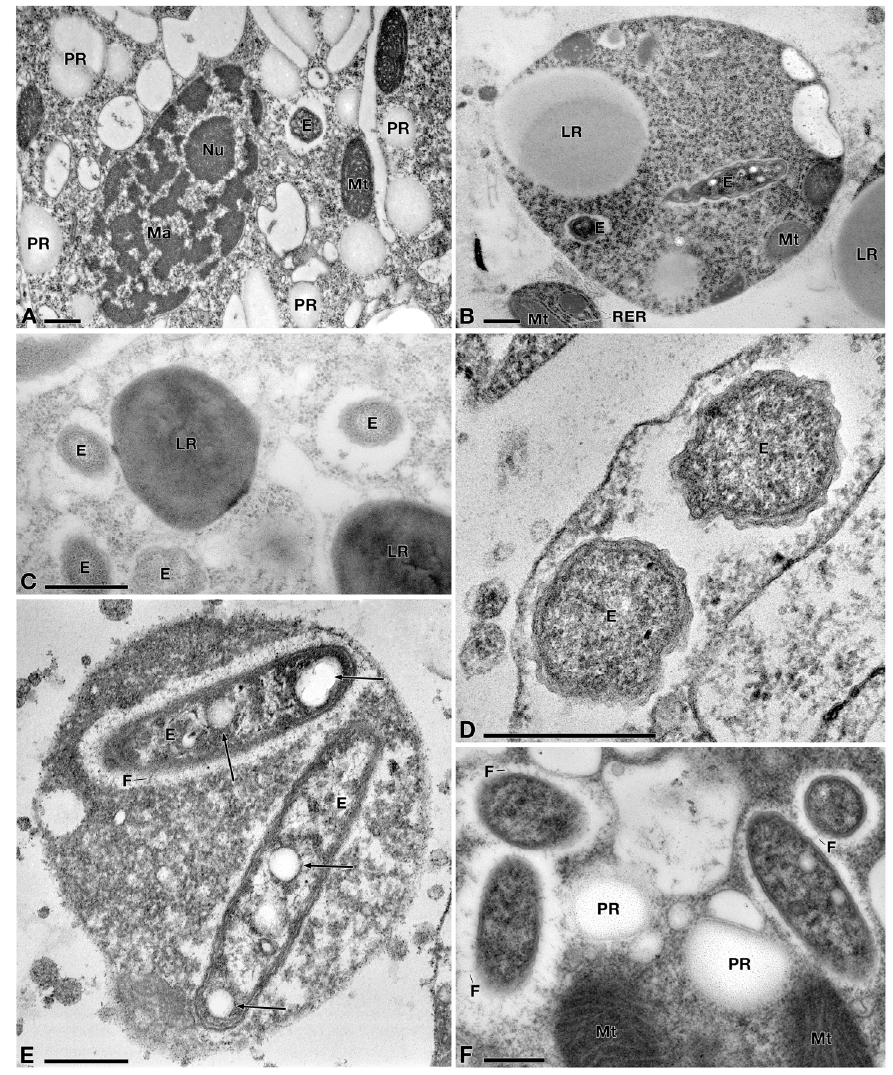
Figure 2. TEM images of Pseudokeronopsis cfr. erythrina PSqRJ01 and its bacterial endosymbionts “ Ca . Trichorickettsia mobilis”. ( A ) In the cytoplasm, a macronucleus (Ma) with a large nucleolus (Nu), several ovoidal mitochondria (Mt) and polysaccharide reserves (PR), and endosymbionts (E) are visible; ( B ) Mt sometimes are associated with ribosomes likely belonging to the rough endoplasmic reticulum (RER) cisternae; ( C ) lipid reserves (LR) often correspond to medium to large-sized droplets. Three endosymbiotic bacteria in the neighbourhood of two LR. They are encircled by a white halo and embedded in the host’s cytoplasm; ( D ) two cross-sectioned endosymbiotic bacteria showing their two-membrane cell wall; ( E ) bacteria are rod shaped, and include areas with variable electron density, electron-lucid granules (arrows), and filaments (DNA); ( F ) sometimes bacteria show flagella (F) distributed all around the cell. Bars stand for 0.5 µm.